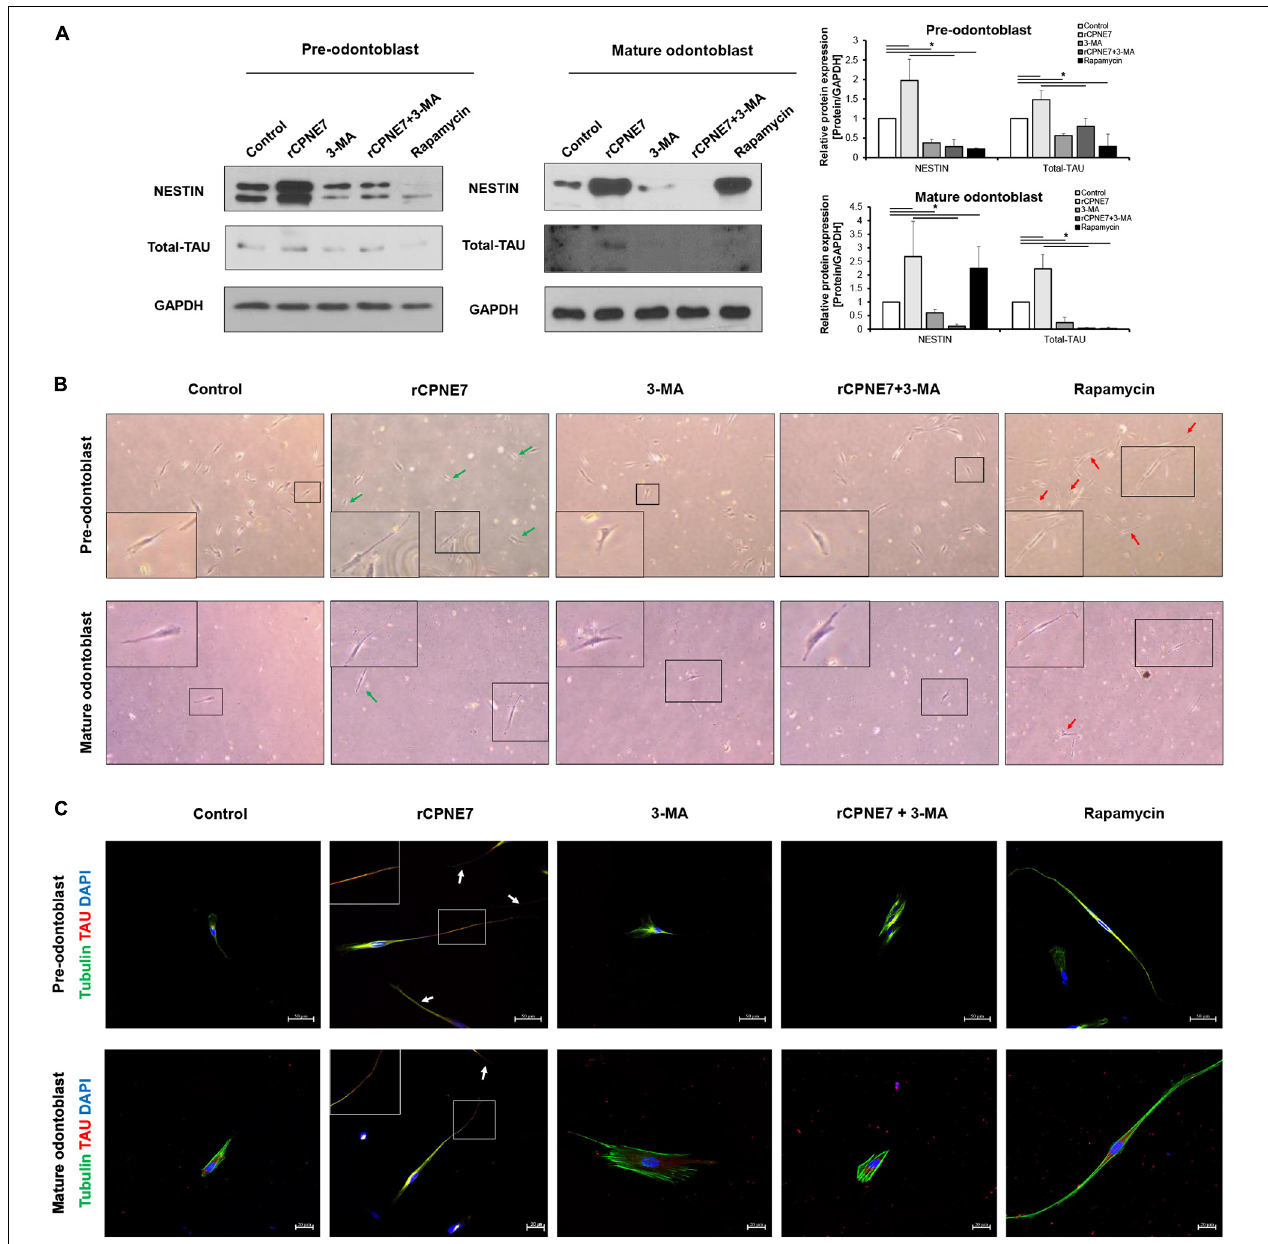
FIGURE 3 | CPNE7 stimulates odontoblast process elongation. (A) Both stages of hDPCs were treated with rCPNE7, 3-MA, rCPNE7 + 3-MA, or rapamycin for 24 h. NESTIN and total-TAU protein levels were evaluated by western blot analysis. (B,C) The morphology of hDPCs was analyzed in each group 7 days after treatment. Boxed areas are shown at higher magnification. (B) Cells were observed under an optical microscope (100 x). Odontoblasts with a unidirectional odontoblast process-like structure (green arrows) were observed in the rCPNE7 group. Multidirectional odontoblast process-like structures were observed (red arrowheads) in the rapamycin group. (C) Representative immunofluorescence images of TUBULIN (green) and TAU (red) in each group of treated cells. TUBULIN and TAU expression was co-localized in the odontoblast process-like structures in the rCPNE7 group (arrows). Scale bars = 50 µ m and 20 µ m. Significant differences are shown with asterisks. * P <